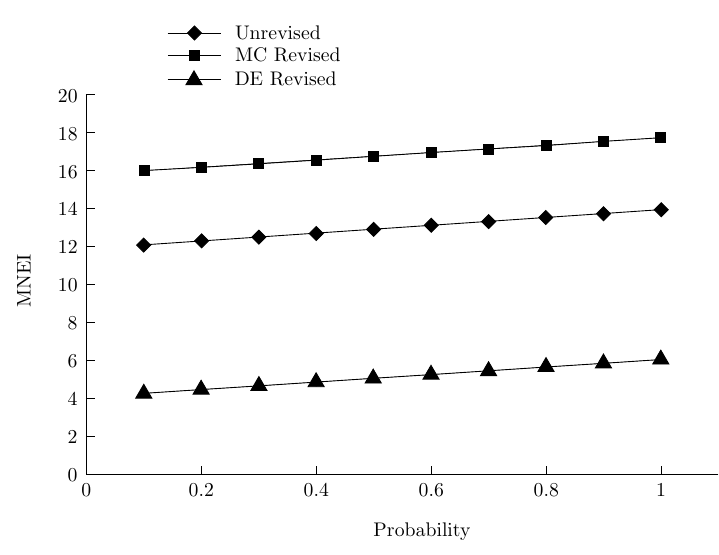
Figure 6: Relationship between MNEI and probability for the 10 × 10